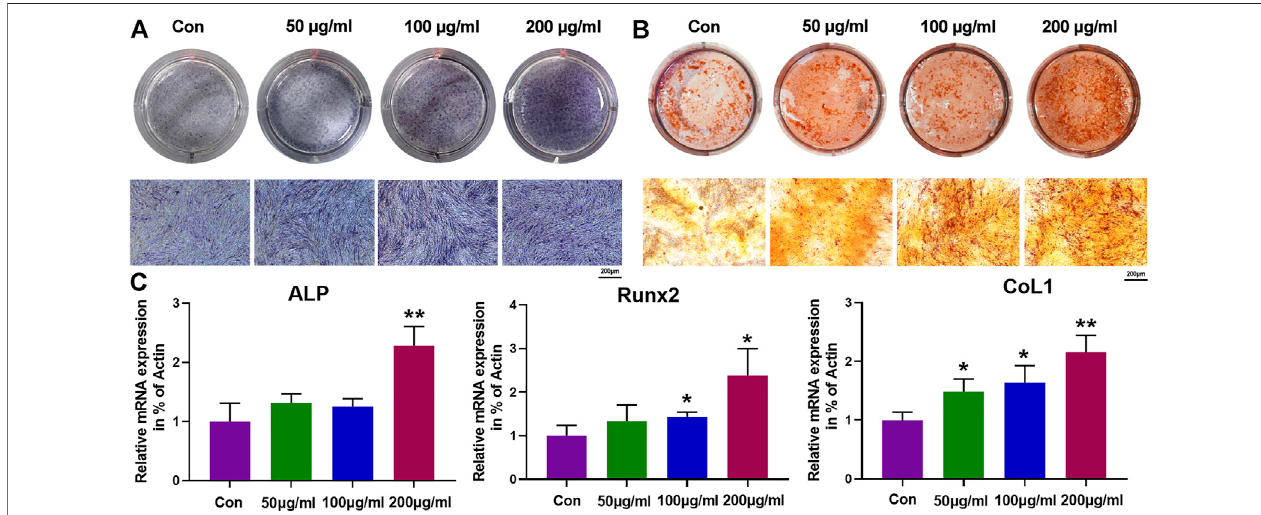
FIGURE 4 | Effects of IONPs on osteogenic differentiation of PCSCs. (A) ALP staining of PCSCs after treated with various concentrations of IONPs (50, 100, and, 200 μ g/ml) for 14 days. (B) ARSstaining ofPCSCs after treated with various concentrations of IONPs (50, 100, and 200 μ g/ml) for 28 days. (C) Real-time PCR analysis of ALP, Runx-2, and COL1 expression of PCSCs after treated with various concentrations of IONPs (50, 100, and 200 μ g/ml) for 3 days. Asterisk indicates statistically signi fi cant differences between the control and experience groups ( p p < 0.05 and pp p <